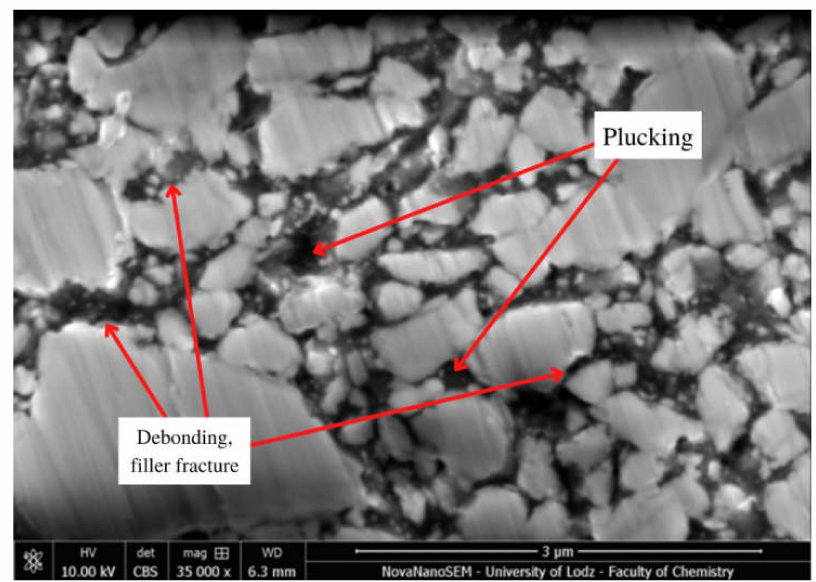
Figure 6. Scanning electron microscopy (SEM) micrograph of Arkon at 35,000 × magnification after Protocol 5 (one week, 60 ◦ C, 0.1 M